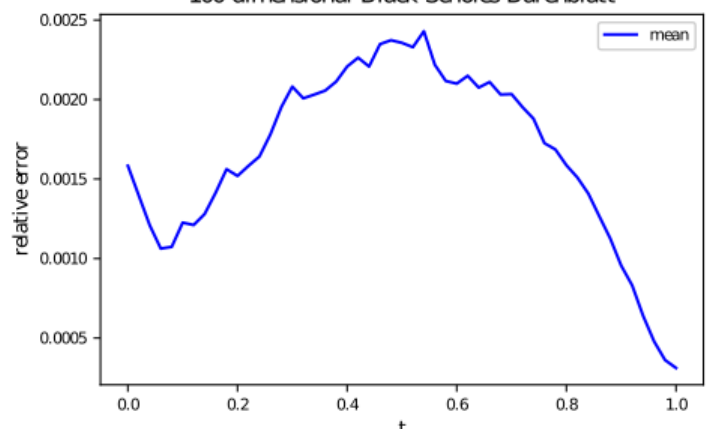
Figure 3. Relative error mean between exact u ( t , X t ) and